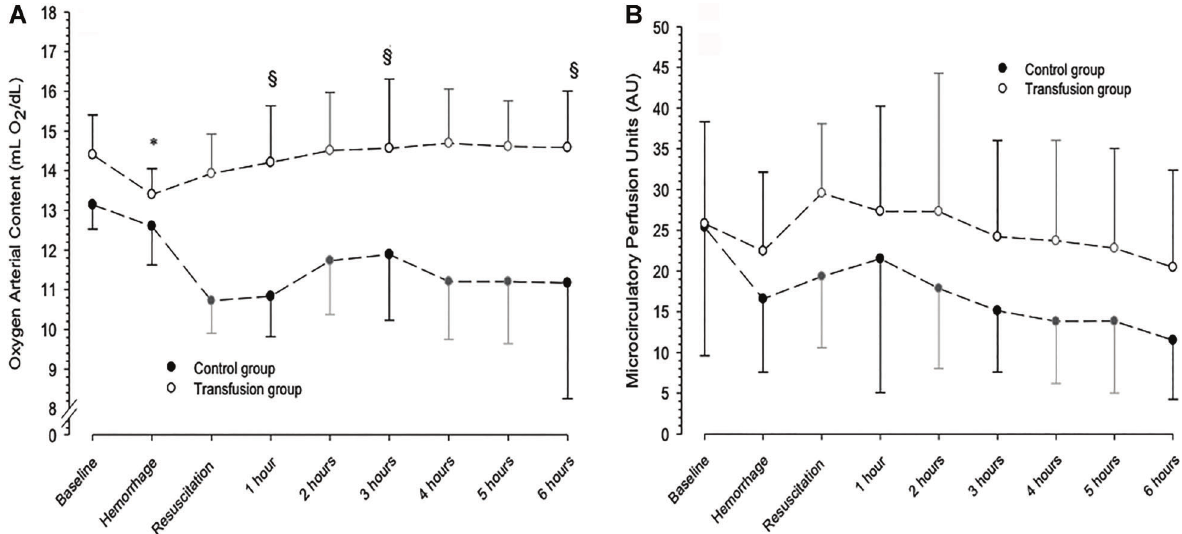
Figure 2. Sequential oxygenation and perfusion parameters of the groups during the study. Panel A , Arterial oxygen content (ANOVA between factor P o 0.001, within factor P=0.039 and factor-time interaction P=0.015). Panel B , Arbitrary microcirculatory perfusion units (ANOVA between factor P=0.026, within factor P=0.146 and factor-time interaction P=0.841). Gray lines and markers denote all data recorded for 8 animals per group. Black markers denote the data that were chosen a priori to be analyzed. *P o 0.05 vs baseline, y P o 0.05 vs hemorrhage ( post-hoc Bonferroni